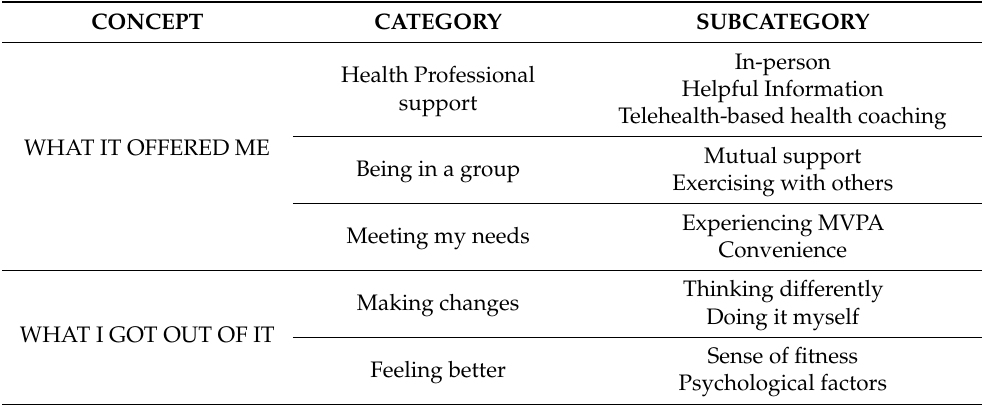
Table 2. Framework for the concepts, ‘What it offered me’ and ‘What I got out of it’ with supporting categories and